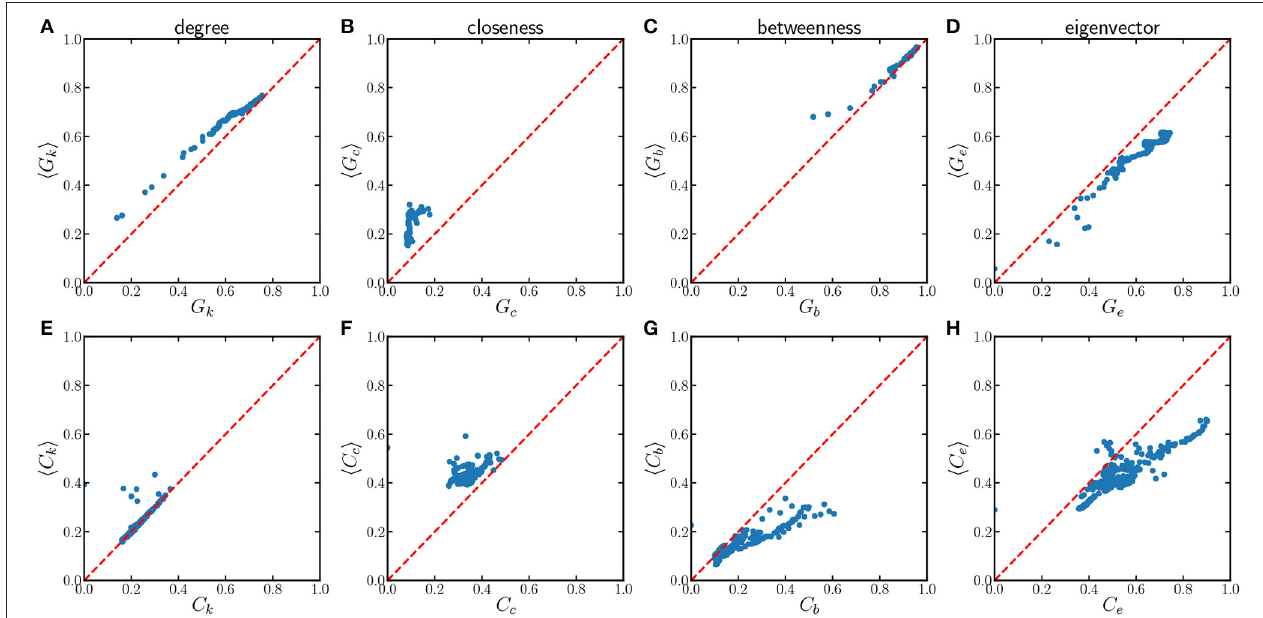
FIGURE 6 | Top panels: comparison between the observed Gini index for the degree (A) , closeness (B) , betweenness (C) and eigenvector centrality (D) on the x-axis and their expected value, computed under the UBCM (y-axis) for the BLN daily-block snapshot representation. Bottom panels: comparison between the observed degree- (E) , closeness- (F) , betweenness- (G) and eigenvector- (H) centralisation measures and their expected value computed under the UBCM. Once the information contained into the degree sequence is properly accounted for, a (residual) tendency to centralisation is still visible, letting the picture of a network characterised by some kind of more-than-expected ’star-likeness’ emerge. See also [ 28].